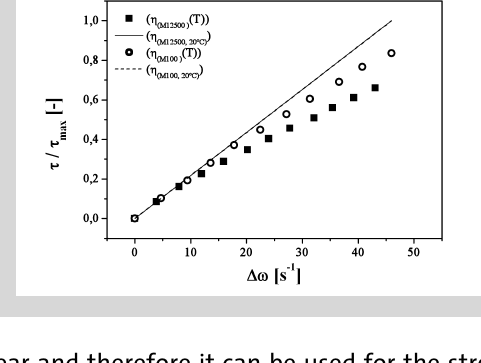
Figure 6 (left above): Silicone oil M100 is used for the fluid coupling as well as for the shear cell as a refer- ence sample. A minimum torque of τ = 0.0455 Pa has R to be applied to overcome the friction of the system. Figure 7 (right above): Silicone oils M100 and M12500 are used for the coupling fluid. The solid line and the dashed line repre- sent the calculation with Eq.1 taking a constant vis- cosity η = 0.11 Pa·s for sili- 20°C cone oil M100 and for sili- cone oil M12500 η = 13.86 20°C Pa·s. The deviation of the applied torque is less than 5 % for angular frequencies up to Δω = 26 s -1 for M100 and up to Δω = 16 s -1 for M12500. Figure 8 (below): The yield stress τ measured y for the MR fluid is propor- tional to the strength of the applied magnetic